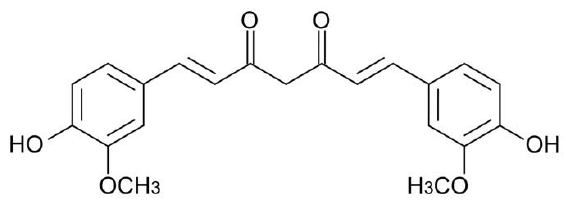
Figure 1. Chemical structure of curcumin.